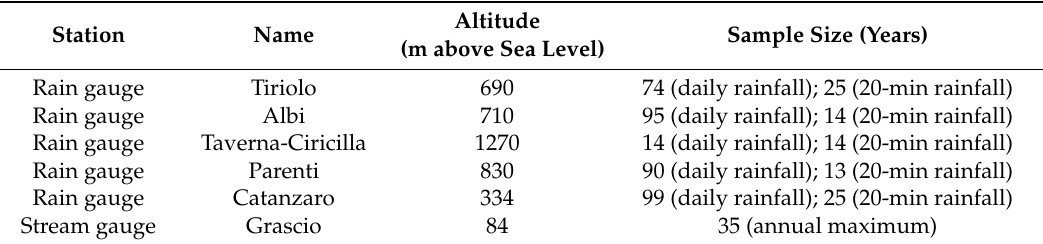
Table 1. Station network referred to Corace at